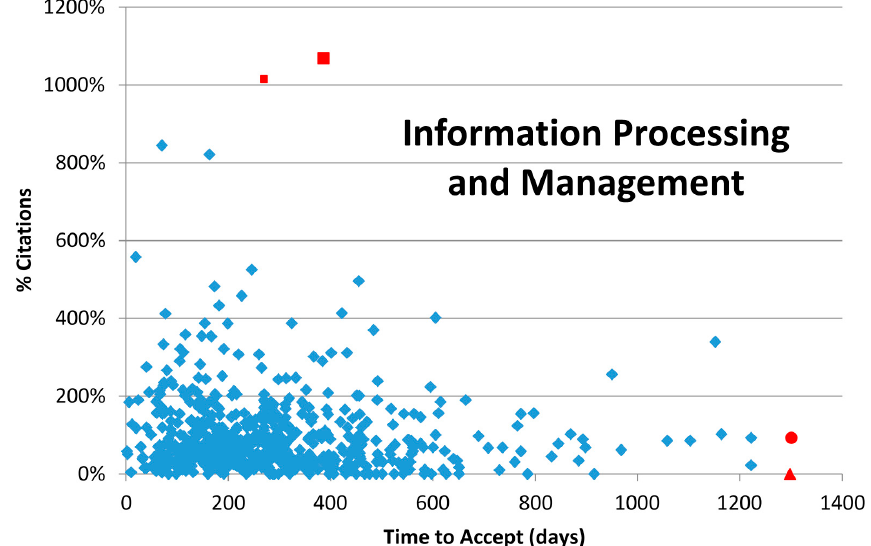
Figure 3. Scatter plot of times to accept versus citations (as percentage ratio of citations to citations per paper in a specific year) of papers from Information Processing and Management ( n = 601, r = ´ 0.06). Extreme outliers are marked with red symbols: A big rectangle Reference [12], a small rectangle Reference [13], a triangle Reference [14], and a circle Reference